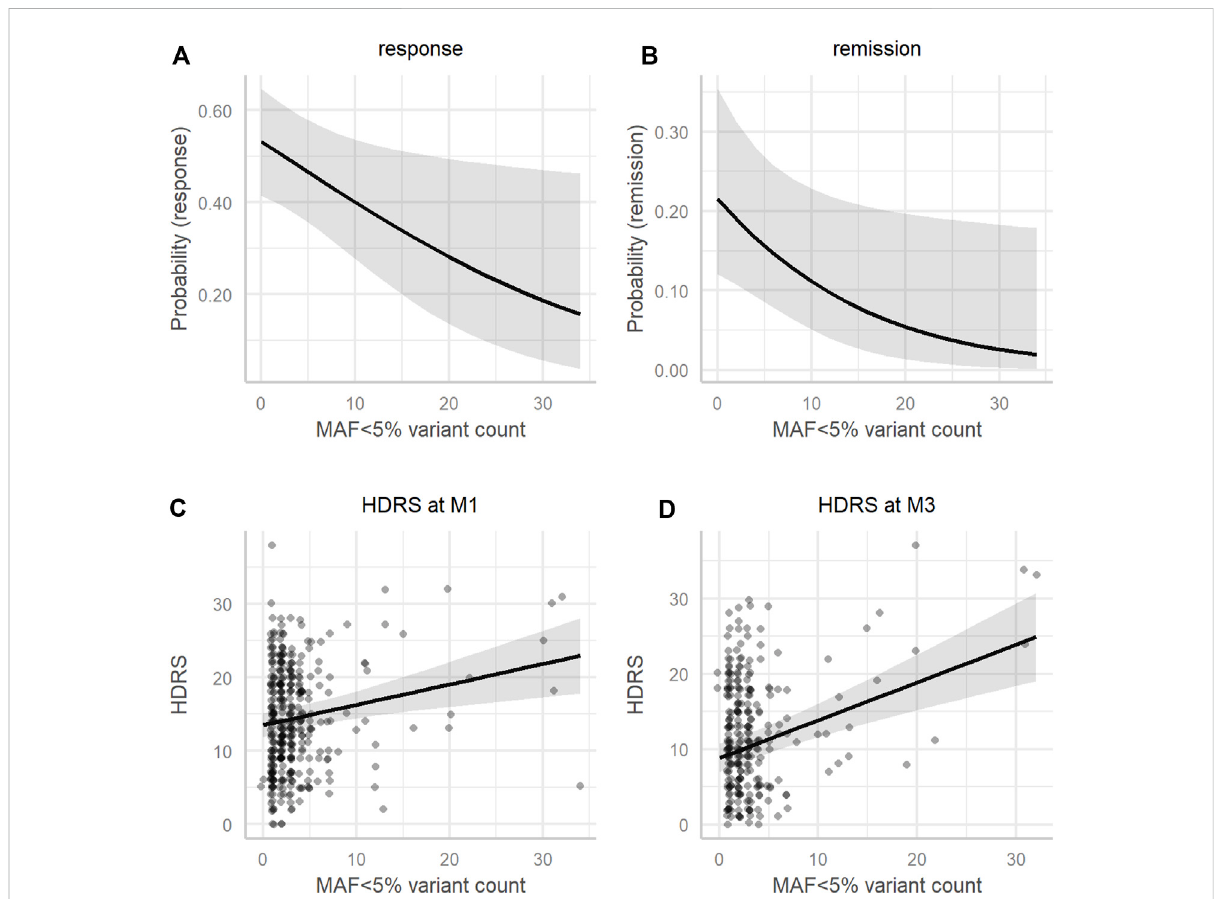
FIGURE 4 AssociationofMAF < 5%variantcountwithclinicalmeasures.Modelestimatesadjustedforthemeanage(45.36),sex(male),andantidepressant class (SSRI) of (A) the probability of response, (B) the probability of remission, (C) the HDRS score at M1, and (D) the HDRS score at M3 ( y -axis) according to the MAF < 5% variant count ( x -axis). HDRS, 17-item Hamilton Depression Rating Scale; M1, 1 month after beginning antidepressant treatment; M3, 3 months after beginning antidepressant treatment; MAF, minor allele